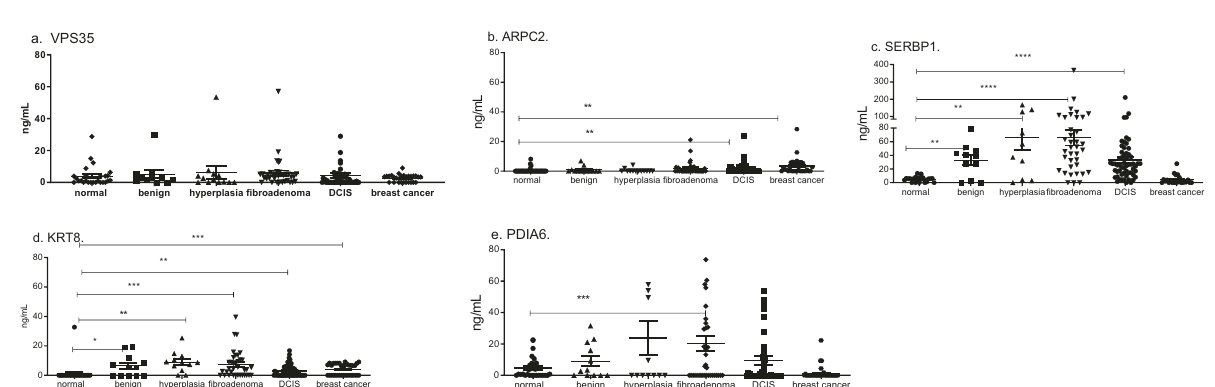
Fig. 5 Autoantibodies against the antigens are increased in patients with breast atypia as compared to patients without breast atypia. Indirect ELISA of sera from women without breast atypia ( n = 43) was compared to sera from women undergoing breast surgery for mammographic abnormalities (benign pathology n = 12, hyperplasia n = 12, fi broadenoma n = 36, or DCIS n = 59), and women with known breast cancer ( n = 37). Y axis is ng/mL IgG antibody concentration by ELISA for each antigen and X axis is the breast pathology a VPS35, b ARPC2, c SERBP1, d KRT8, and e PDIA6 Error bars are standard error of mean (SEM) **** p < 0.0001, *** p < 0.001, ** p < 0.01, * p <